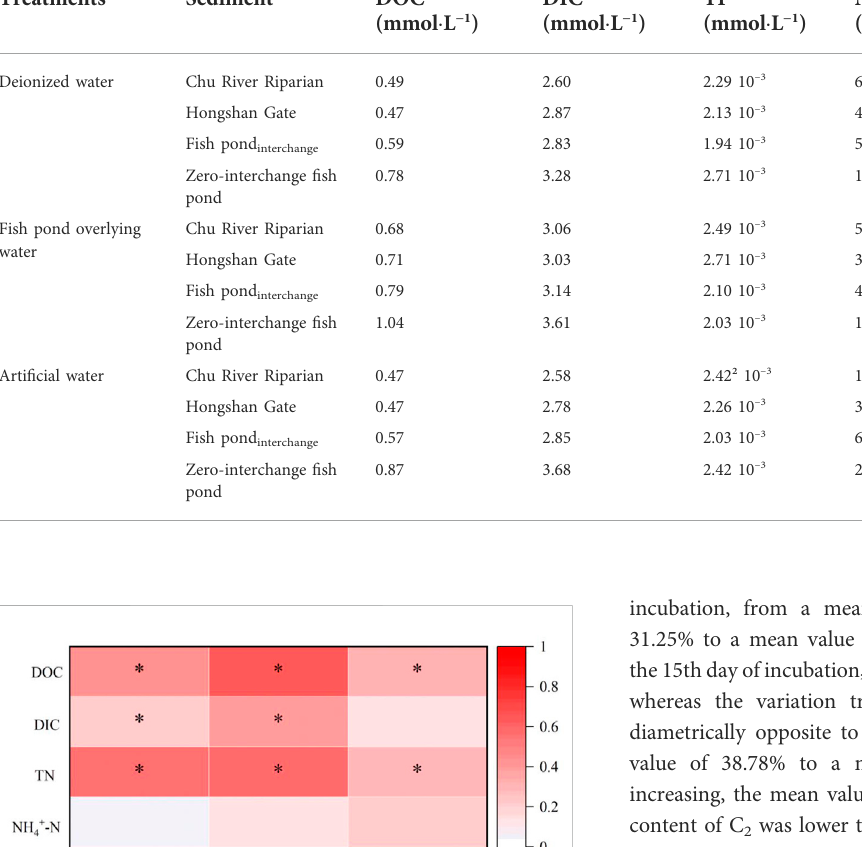
TABLE 2 Variation of hydrochemical parameter for different treatments in microcosm incubation. Treatments